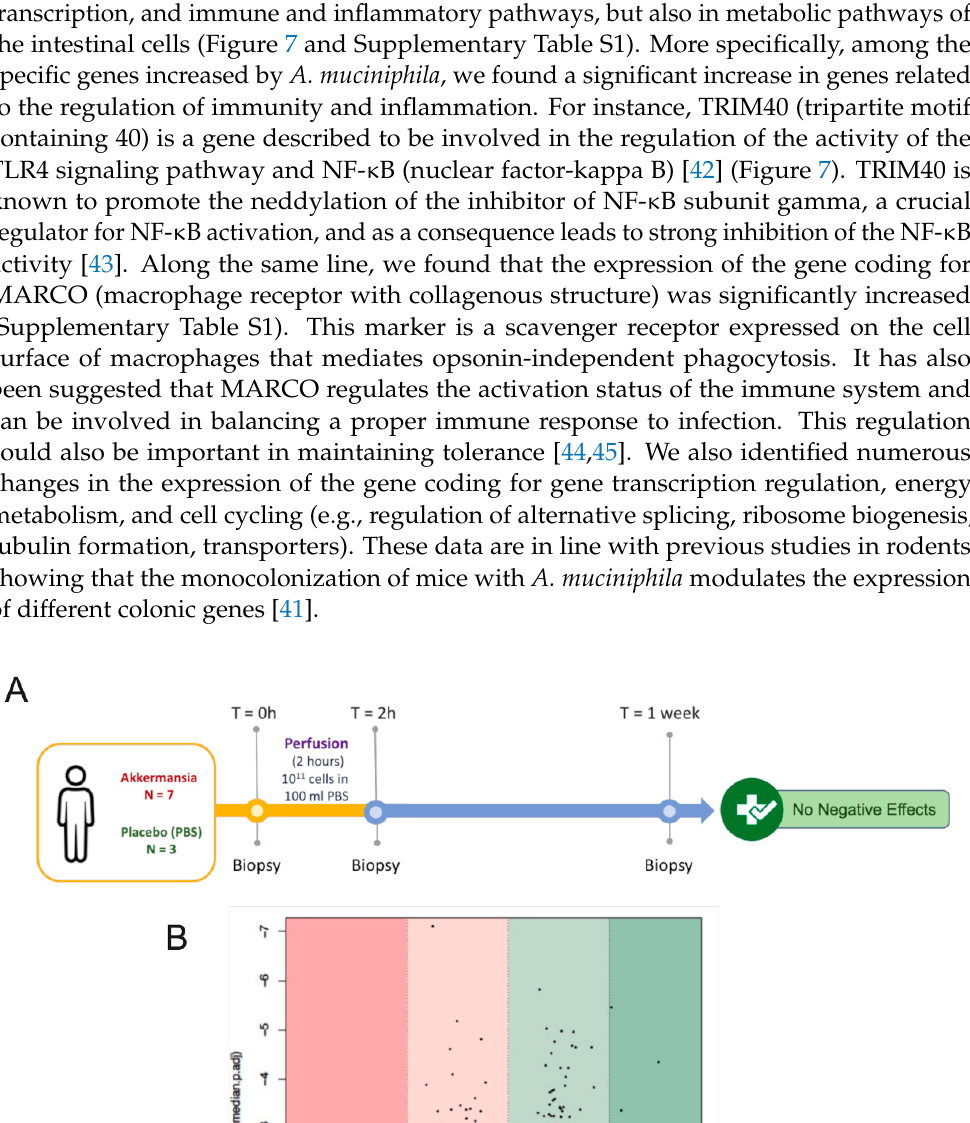
Figure 7. Proof-of-concept study in healthy humans treated 2 h with A. muciniphila on gene ex- pression versus baseline treatment and placebo . ( A ) Experimental design and volcano plot show- ing transcriptional analysis on colonic biopsies after 2 h perfusion versus basal. ( B ) Dark and light pink left parts of the volcano plot represent the genes downregulated 2 h after exposure to A. mu- ciniphila , whereas the dark and light green on the right part represent the genes upregulated 2 h